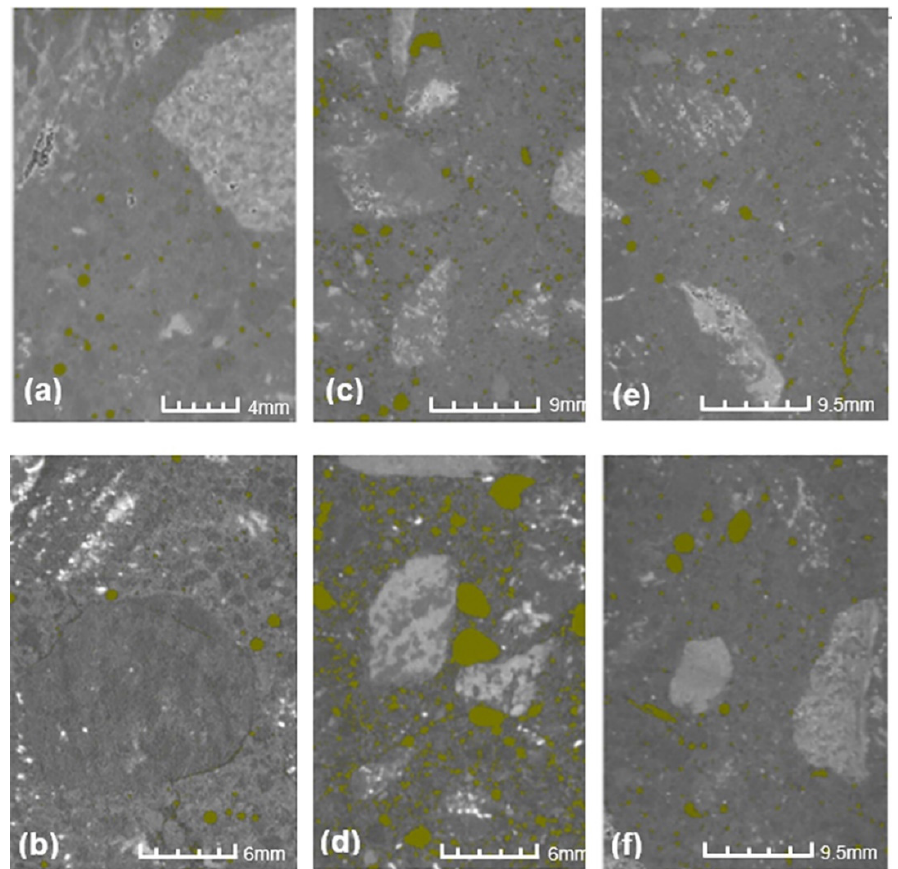
Figure 8. Air voids identification in computed tomography (CT) images: ( a ) CREF before heating; ( b ) CREF after heating; ( c ) CPP3 before heating; ( d ) CPP3 after heating; ( e ) CPW3 before heating; ( f ) CPW3 after heating.